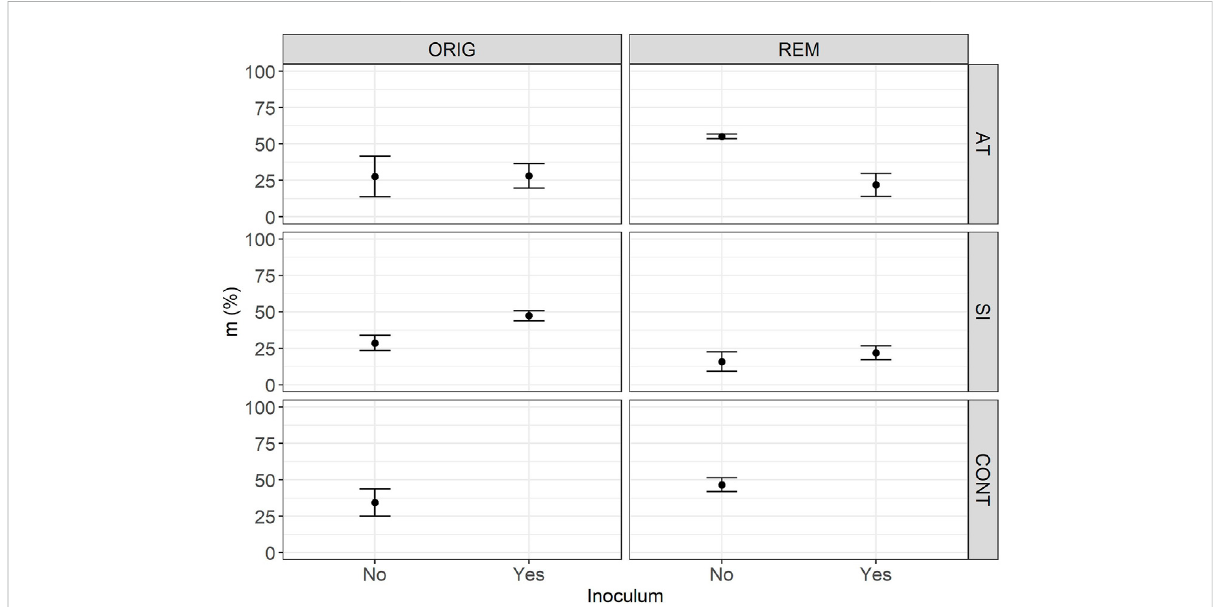
FIGURE 4 Mean intensity of mycorrhizal colonisation in root fragments (m) in Lolium perenne L. in Austrian (AT), Slovenian (SI) and control (CONT) soil, before (ORIG) and after remediation (REM). Root sampling on 17 November 2017. The addition of indigenous inoculum (rhizosphere soil and roots from a grassland) is marked yes/no. Shown are the measured values of mean and SE.